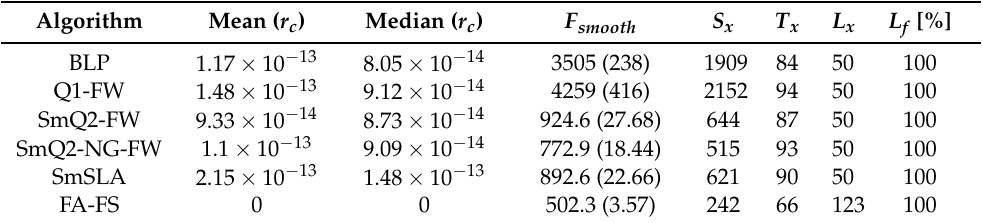
Table 3. Results obtained for the largest farm with 256 ports, 252 EVs, and constant charging rate. The maximal number of EVs that can be charged in one time slot is restricted to 50 owing to the power limit.